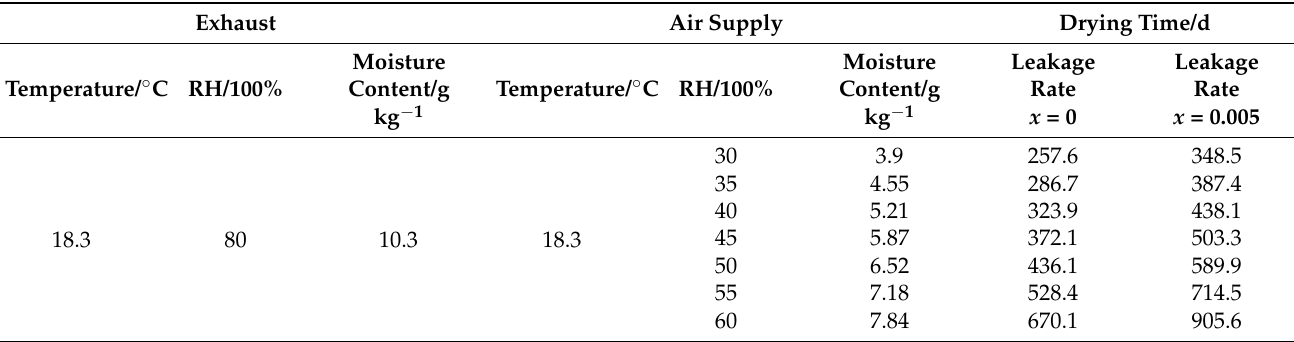
Table 4. Drying time of the main cable.